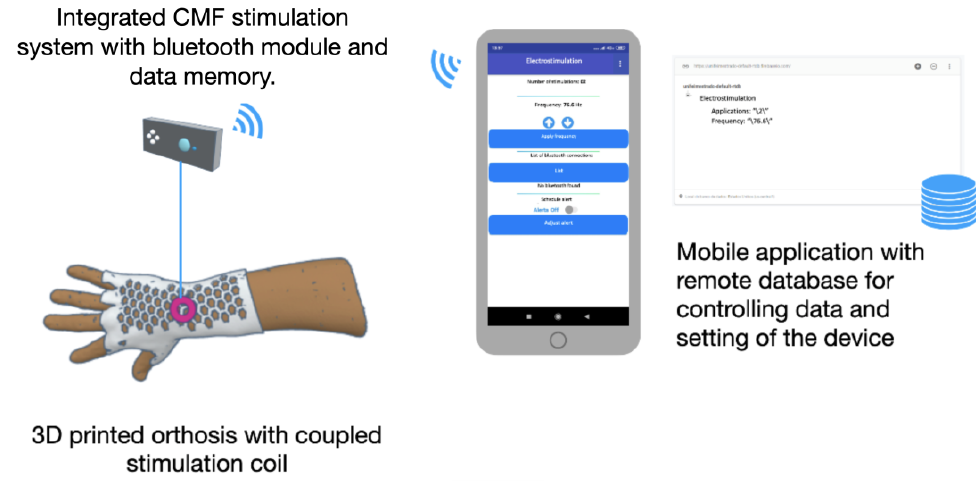
Figure A5. Integrated system, represented by the orthopedic mesh positioned over the fractured arm with an electrostimulator coupled in communication with a mobile application and a remote database.